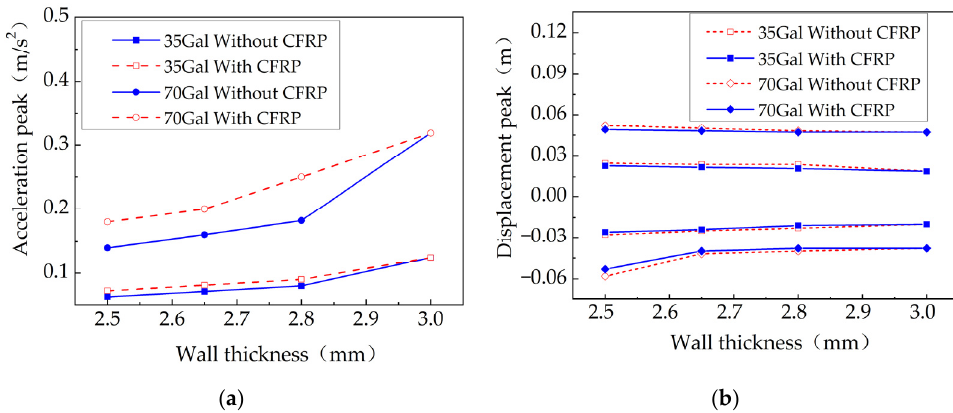
Figure 29. Dynamic response of structure under the Hyogoken-Nanbu earthquake: ( a ) Comparison of acceleration peak; ( b ) Comparison of displacement peak.